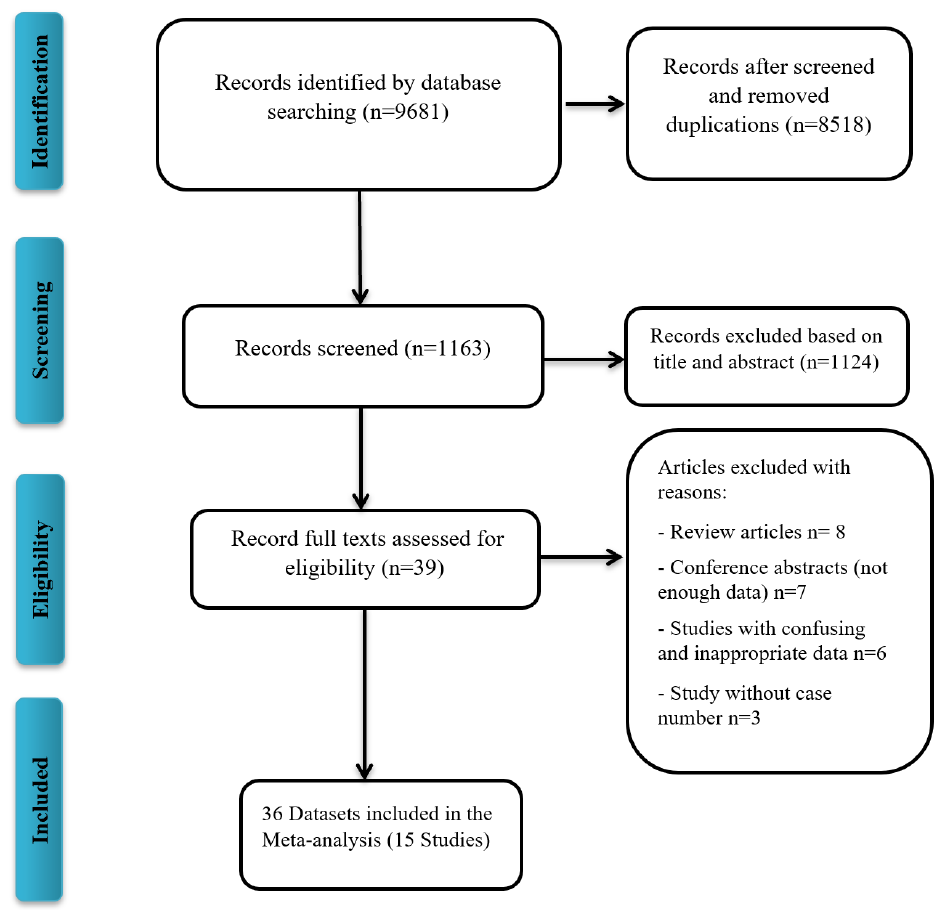
Figure 1. Flow diagram of literature search and study selection for meta-analysis (PRISMA flow chart) . Table 1. Characteristics of included publications.